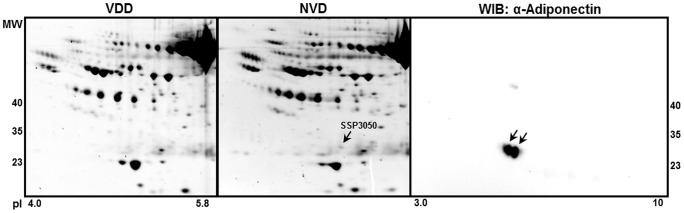
Proteomic evaluation predicts adiponectin isoforms as being differentially expressed between VDD and NVD.A 2D-electrophoretic analysis was performed in duplicate for the 42 subjects using IPG3-10, with proteins detected by Sypro Ruby staining. Spot/s predicted to be adiponectin are indicated by the PDQuest identification number (SSP3050). Supportive evidence for the prediction was given by performing a WIB of 2D-electrohoretic gels using anti-adiponectin antibody. Representative gels are shown.